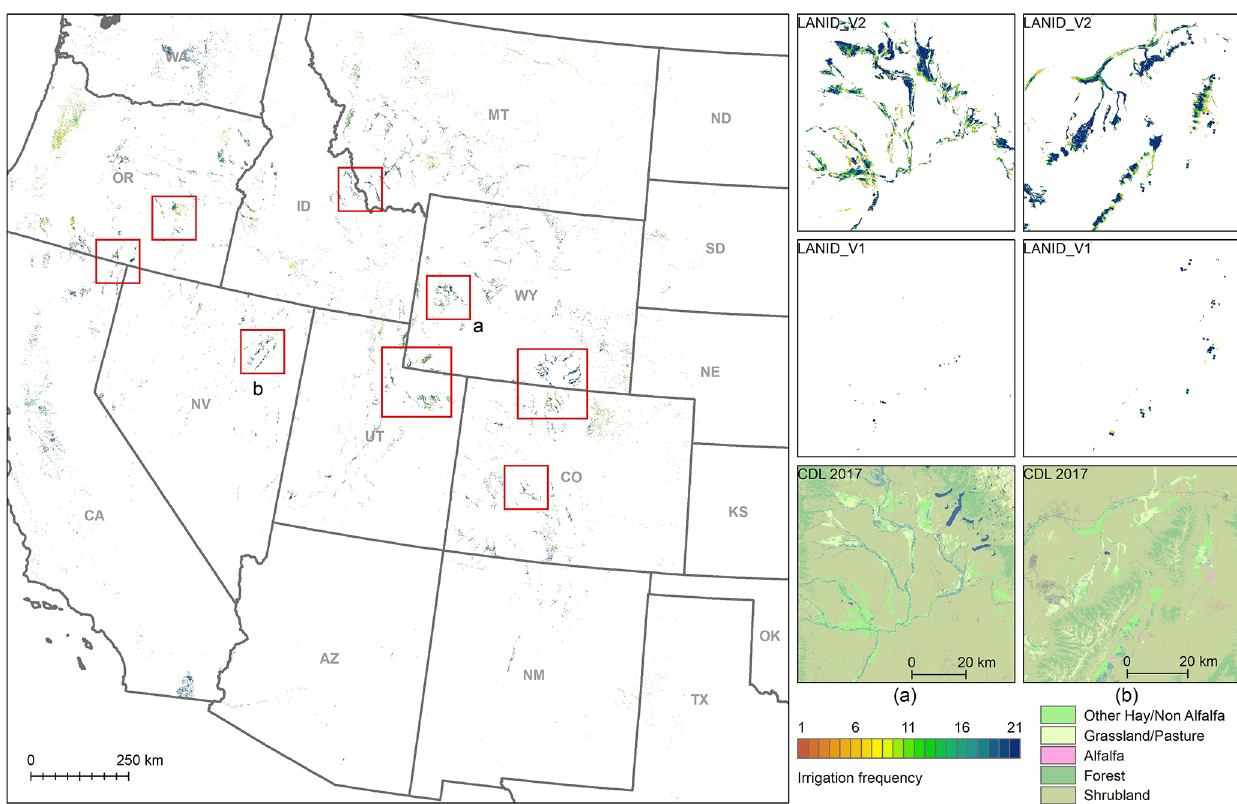
Figure 8. Distribution of irrigated pasture and hay derived from LANID_V2 (presented in this study) in the western CONUS. The overview shows irrigation frequency (i.e., the number of years a pixel is irrigated during 1997–2017). The highlighted areas in the red rectangles represent areas of intensively irrigated pasture and hay that were not completely mapped in LANID_V1. Panels (a) and (b) are examples of local views for western Wyoming and northeastern Nevada, respectively.